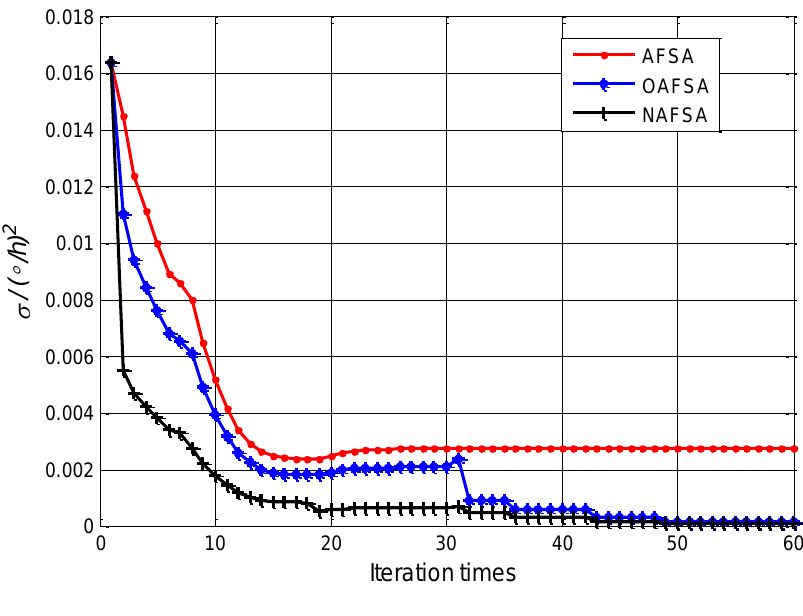
Figure 4. Indicator functions of SAFSA, OAFSA and